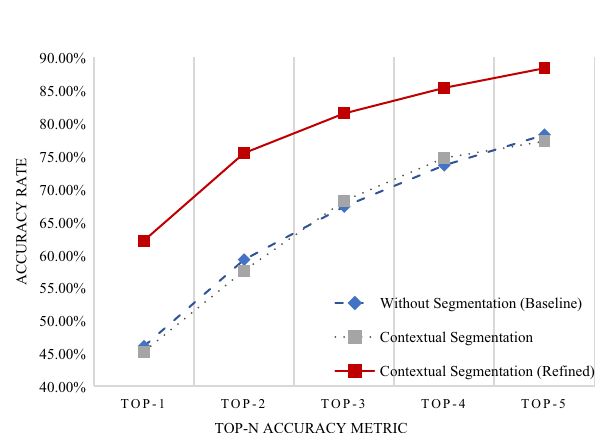
Figure 2. Accuracy rate for classification. The x-axis represents the Top-n accuracy metric, while the y-axis represents accuracy. The blue line is the accuracy of the model trained without segmentation. Images did not enter the U-Net before entering the EfficientNet. The gray line represents the accuracy of the model trained with segmentation. Images were segmented and cropped through the U-Net before entering the EfficientNet. The red line represents the accuracy of the model trained with segmentation and refined data. Images were segmented, cropped, and verified to ensure that segmentation had been done correctly before entering the EfficientNet. An open- source implementation of the EfficientNet (v0.7.0) is available at https ://githu b.com/lukem elas/Effic ientN et-PyTor